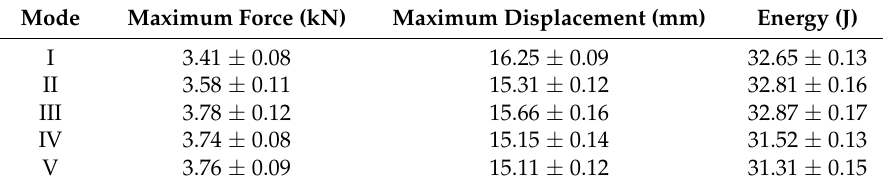
Table 3. Impact responses of the sandwich panels without or with one layer of SMA